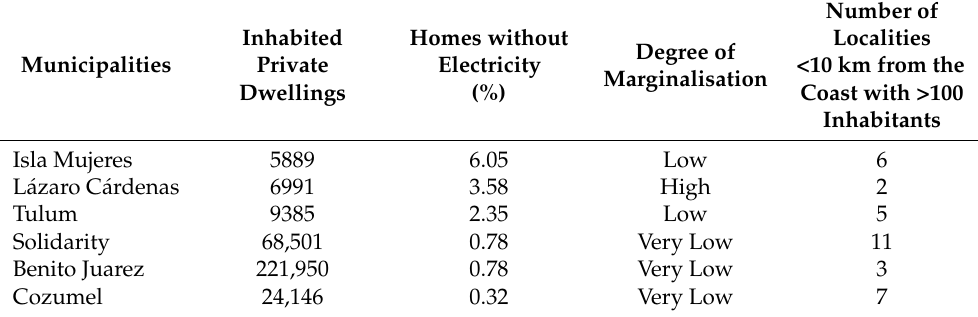
Figure 10. Percentage of households without electricity. Table 9. Municipalities in Quintana Roo with the highest percentage of inhabited private dwellings without electricity and their degrees of marginalisation. Own elaboration with information obtained from [35,36,39].